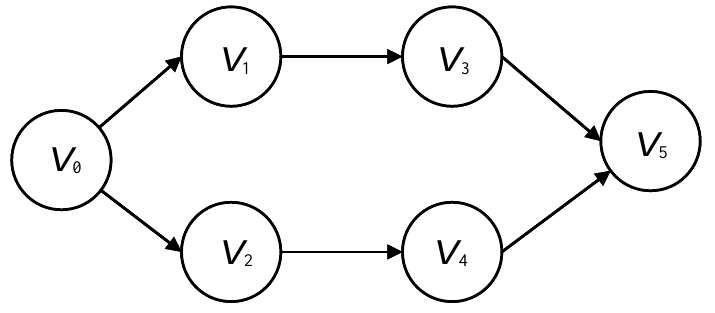
Figure 2. Workflow directed acyclic